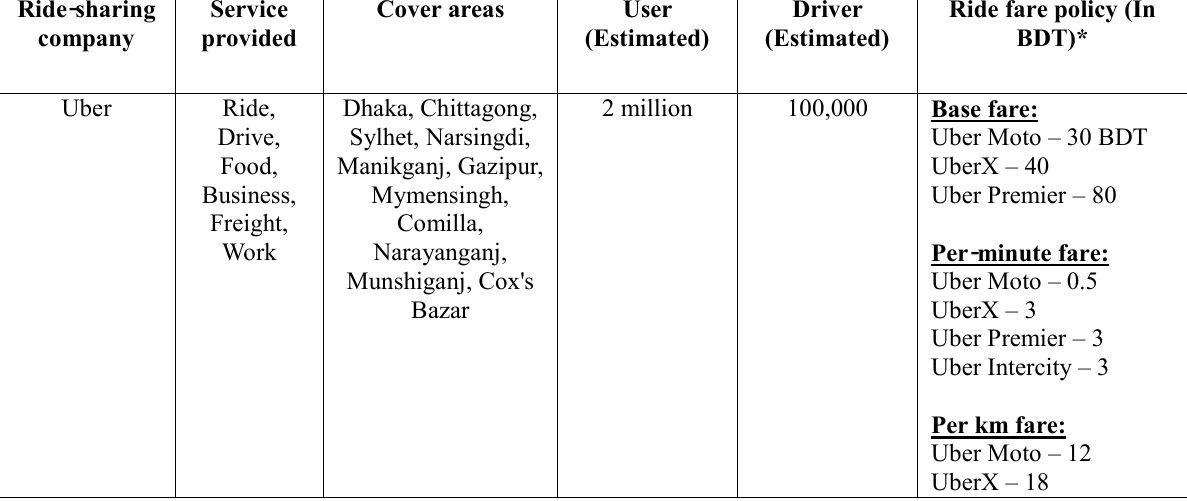
Observations of each ride-sharing company in Bangladesh with their services, cover areas, users, drivers, and ride fare